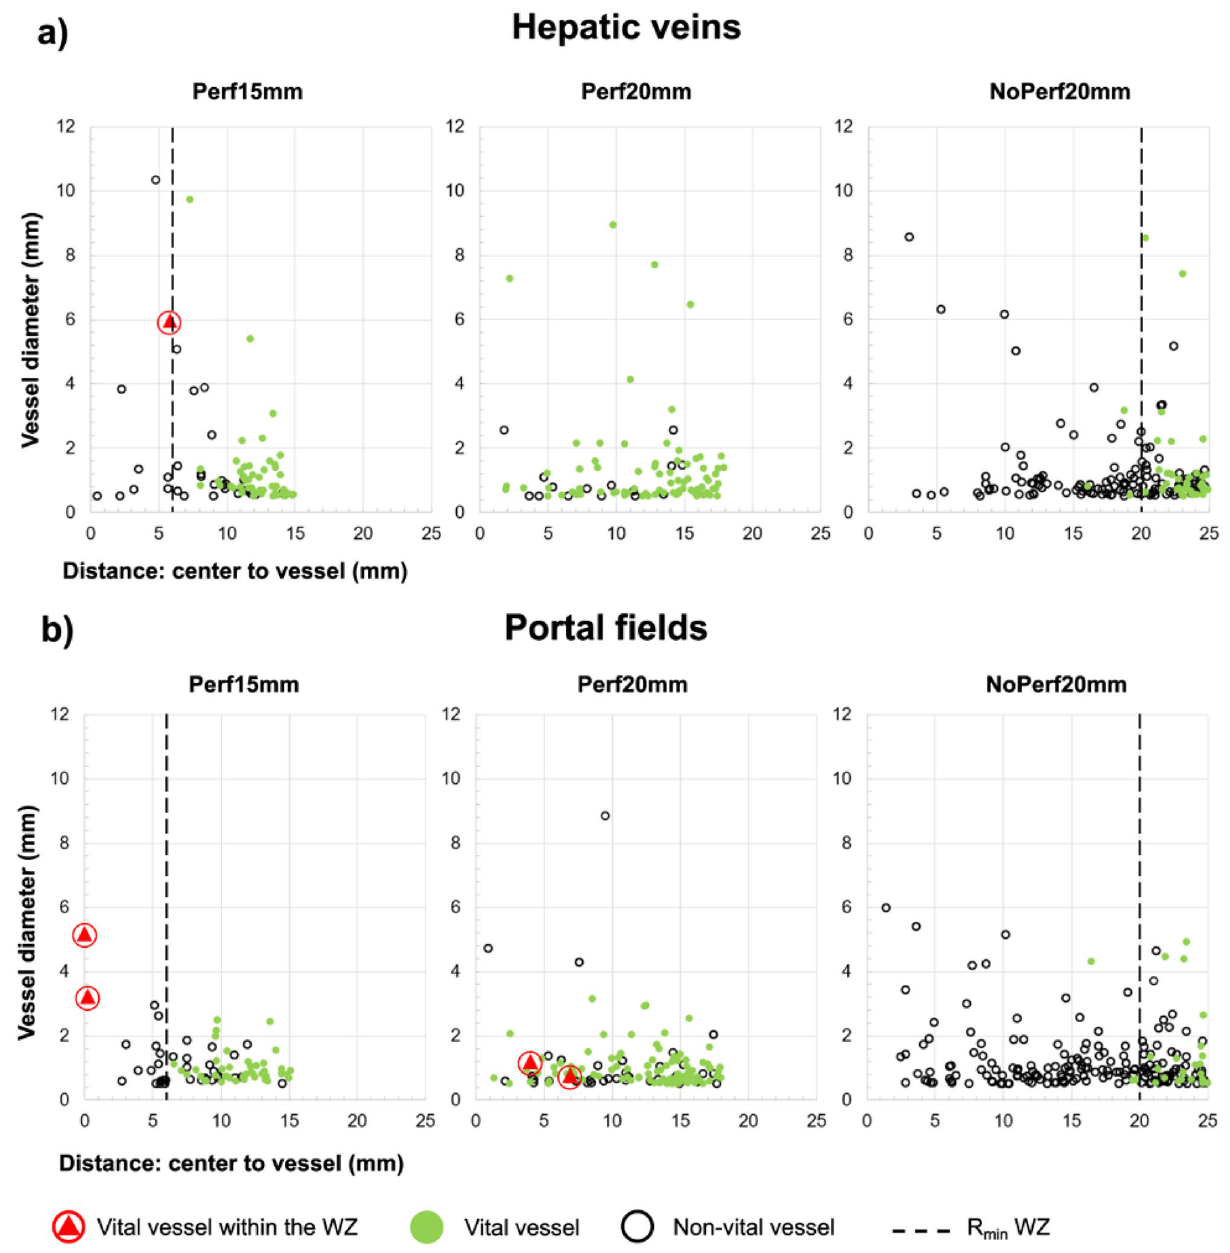
Figure 2. Visualization of all hepatic vessels (n = 771) in dependence of vessel type and experimental setting. Tissue around these vessels was either circularly ablated (black circles) or (partly) vital (green dots). The vertical dashed line shows the median minimal ablation radius (R min white zone) of the respective test series. This line indicates the minimum ablation size. No minimal ablation radius could be shown for Perf20mm, since the ablation center was not ablated in 75% of the cases. Red encircled triangles indicate incomplete ablation adjacent to vessels situated within the WZ. This is of particular importance as no vital cells are expected within this